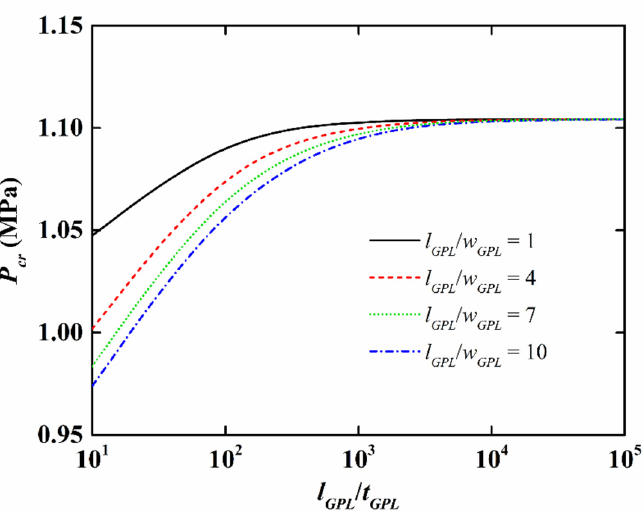
Figure 11. Variation in critical pressure of ring-stiffened porous GPLRC cylindrical shells with porosity coefficients for different porosity distributions. The variations in the critical pressures with various ring-stiffener heights ( d F / h F = 0.5) and ring-stiffener spacings are presented in Figures 12 and 13, respectively. It can